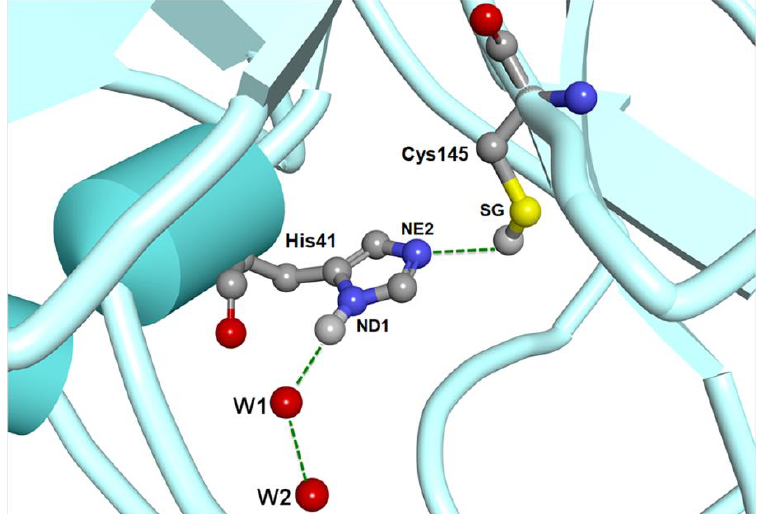
Figure 1. The catalytic region of Mpro contains His41 and Cys145 (dyad), and lacks the third residue, which is replaced by a stable water molecule W1 (W639) and W2 (W864) in the 6YB7 crystal structure. The thiolate–imidazolium ion-pair may be formed between SH of Cys145 and NE2 of His41, whereas W1 makes H-bond with H atom of ND2 of His41. The Main protease enzyme indicates the possibility of an alternative catalytic mechanism for the